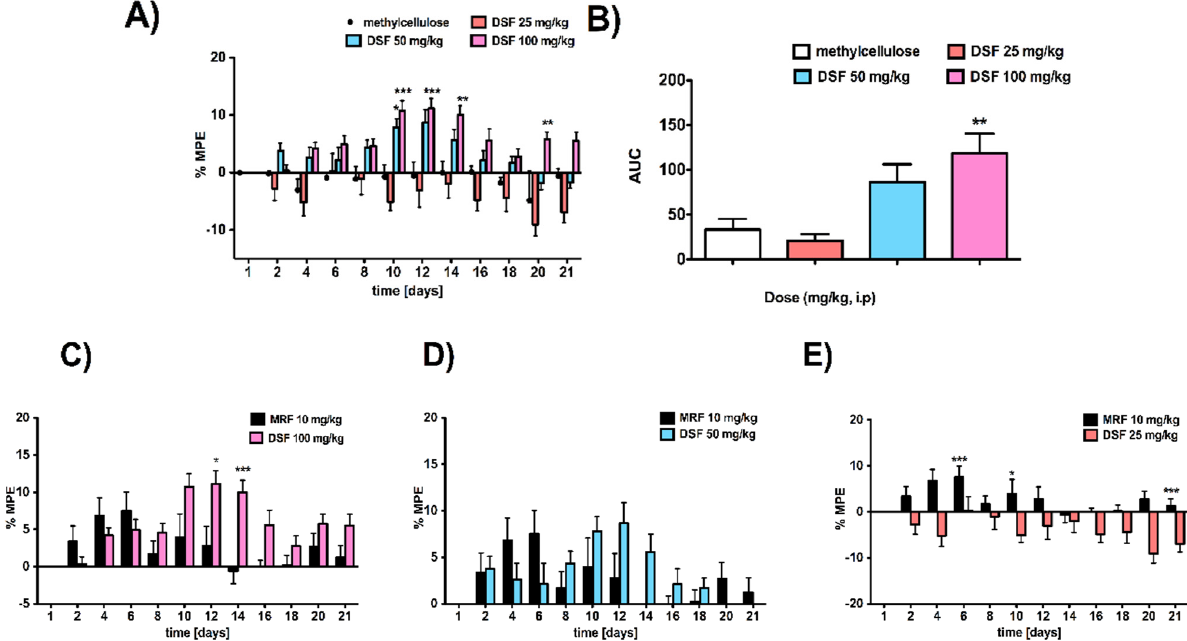
Figure 2. The pain-relieving effect induced by subacute (21 days) intraperitoneal administration of disulfiram (DSF). ( A ) Dose-dependent antinociceptive effect of DSF on thermally induced pain. ( B ) The area under the analgesia–time curve (AUC) after treatment with various doses of DSF vs. vehicle. ( C , D , E ) DSF (100, 50, and 25 mg/kg, respectively) effect in comparison to morphine (10 mg/kg; i.p.). Results were analyzed either with two-way ANOVA followed by Bonferroni’s post hoc test or one-way ANOVA, followed by Dunnett’s post hoc test. DSF activity was compared with a vehicle-given group (0.1% methylcellulose, i.p.). Data from every second day, starting from day 2, were omitted. Results are presented as the % of maximal possible effect (%MPE) ± SEM (9 or 10 rats per group). * p < 0.05, ** p < 0.01, and *** p < 0.001 indicate significant differences between DSF-treated and vehicle-treated rats ( A , B ). * p < 0.05 and *** p < 0.001 indicate a significant difference between morphine (MRF)- and DSF-treated animals (100 mg/kg) on 12th and 14th day of repeated once-daily intraperitoneal administration ( C ), respectively. * p < 0.05 and *** p < 0.001 indicate a significant difference between MRF- and DSF-treated animals (25 mg/kg) on 6th, 10th, and 21st day of repeated once-daily intraperitoneal administration ( E ), respectively. Rats treated with methylcellulose served as a control group; n = 10 animals (male Wistar rats)/group.